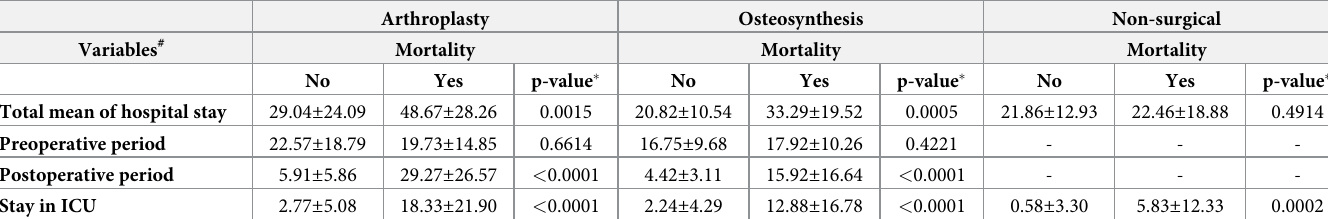
Table 5. Total mean of hospital stay, preoperative period, postoperative period and days in ICU when comparing the surviving and mortality groups, regarding the surgery performed.